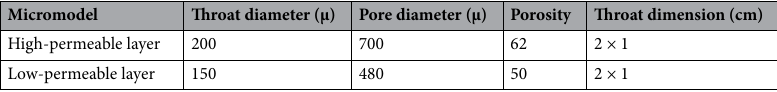
Table 2. Specifications of the under-test micromodel.